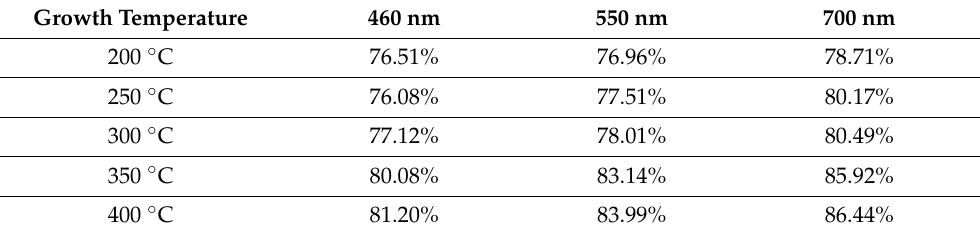
Figure 8. Optical properties of 1.0 wt.% WZO films deposited under 200 – 400 °C. Table 2. Transparencies of 1.0 wt.% WZO films deposited under different growth temperatures (200 – 400 °C) at the wavelengths of 460, 550, and 700 nm.